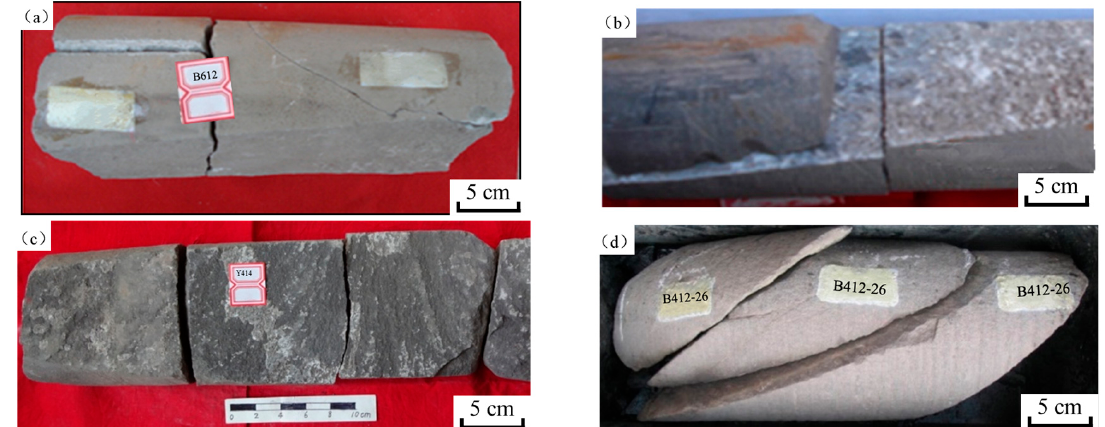
Figure 3. Core photos, ( a – c ) high-angle fractures, ( d ) low-angle fractures.